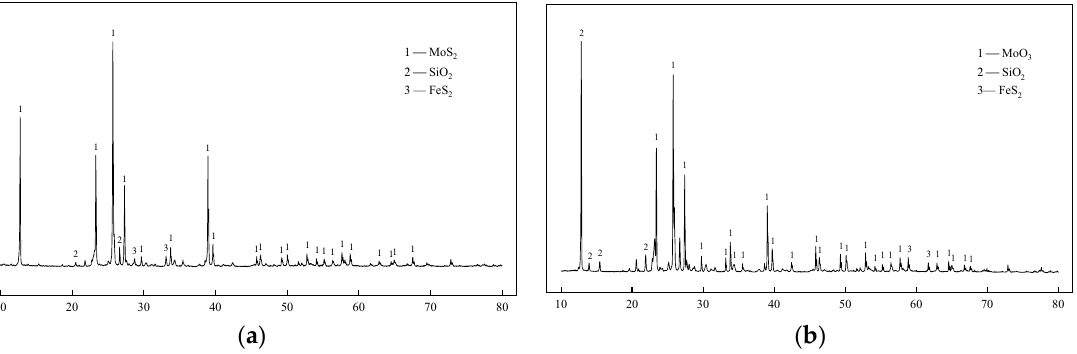
Figure 3. XRD analysis of molybdenum concentrate and molybdenum calcine. ( a ) molybdenum concentrate; ( b ) molybdenum calcine.